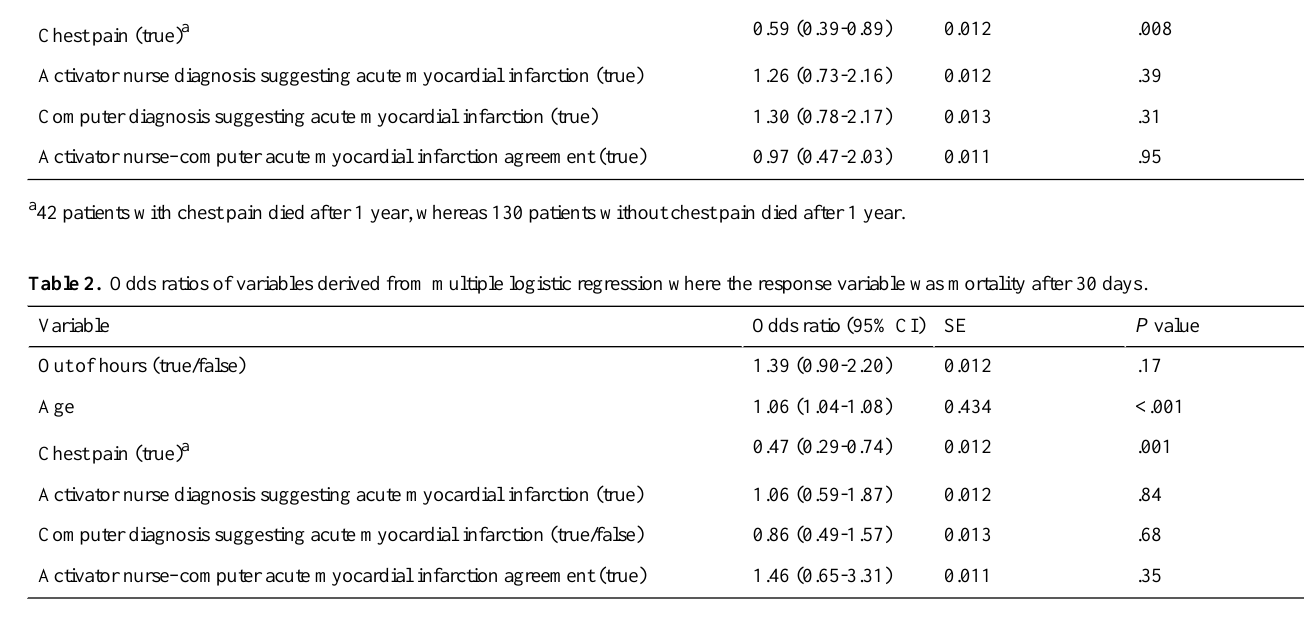
P valueSEOdds ratio (95% CI)Variable